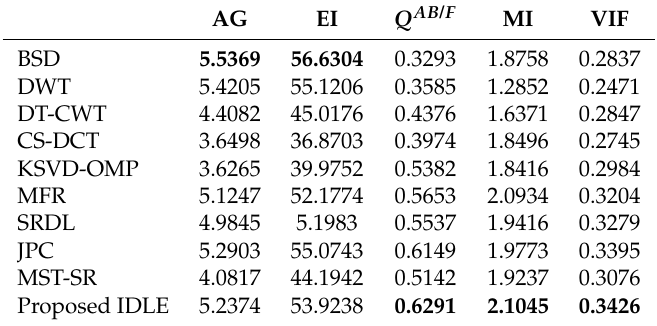
Table 4. Average Objective Evaluations of Nine Image Fusion Comparative